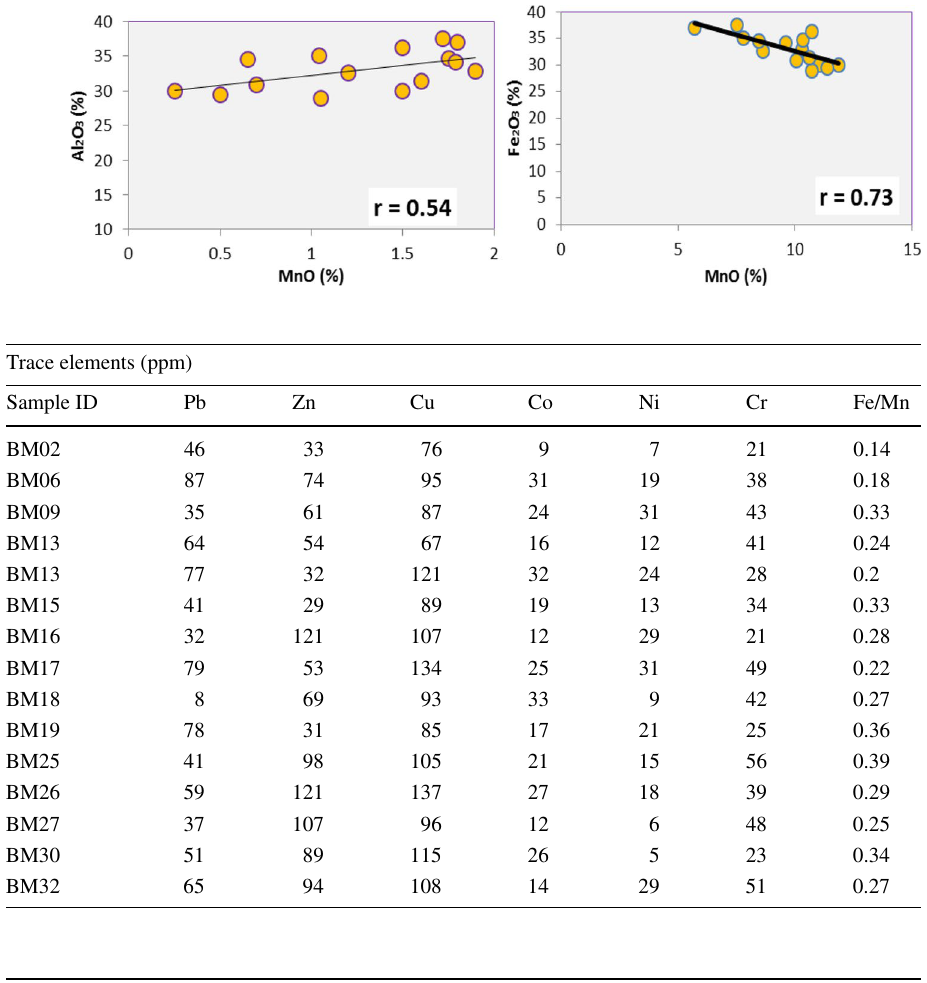
among major oxides and some selected trace